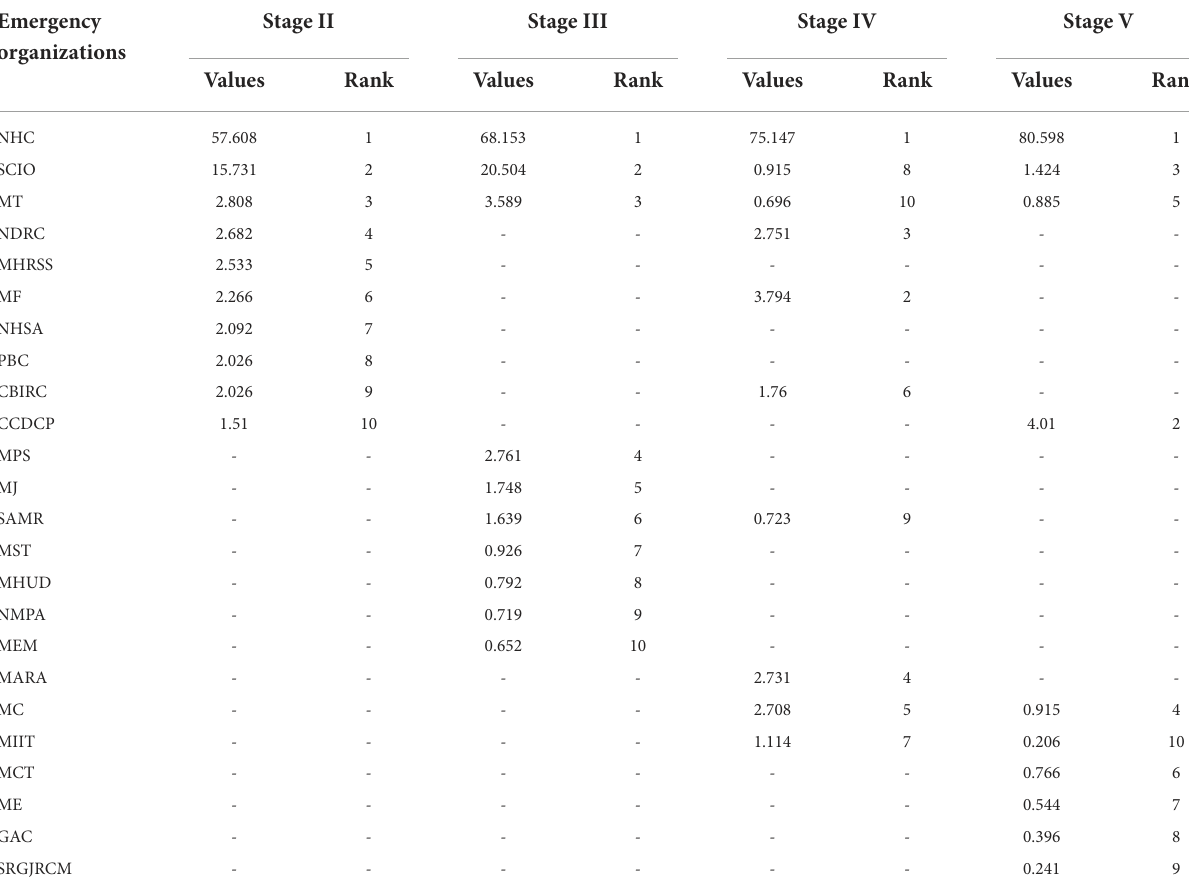
TABLE 5 Top 10 EOs with the normalized betweenness centrality in Stages